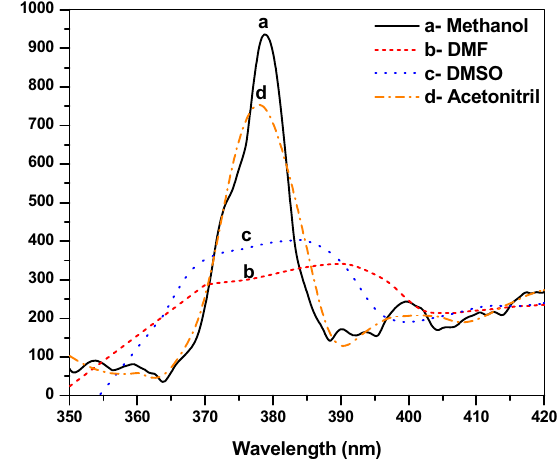
Figure 4: Fluorescence emission spectra of the L sensor in the pre - sence of di ff erent solvents at λ ex / λ em = 340/380